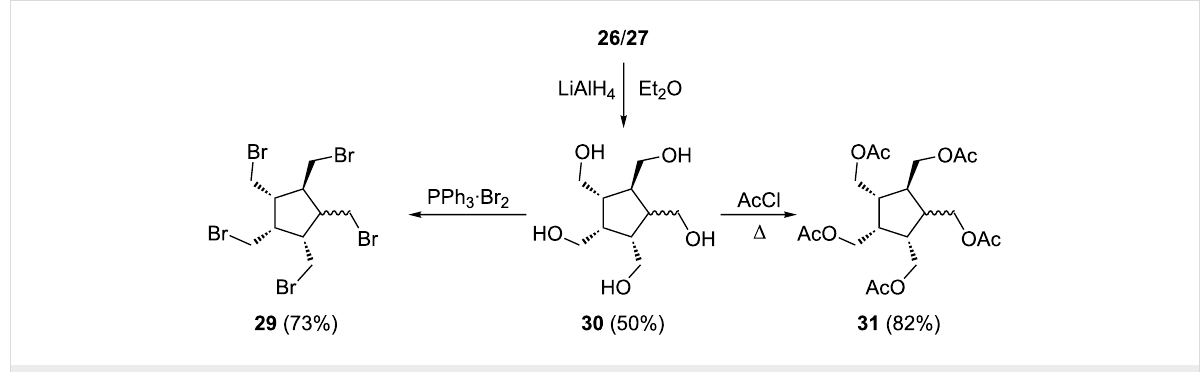
Scheme 6: Derivatives derived from the pentaester mixture 26 / 27